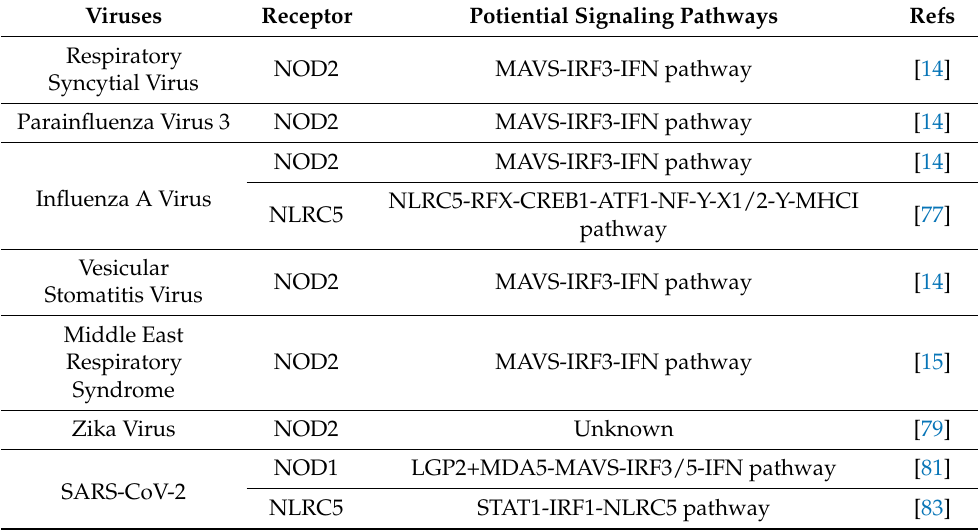
Table 2. Viruses stimulating NOD1, NOD2, or NLRC5